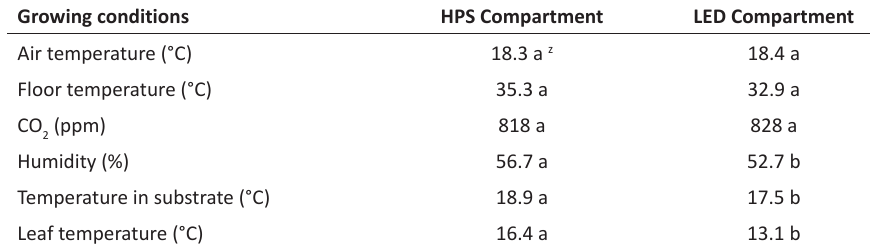
Table 1. Microclimate conditions, leaf temperature of red winter lettuce ( Lactuca sativa ‘Carmoli‘) and temperature of the substrate in the greenhouse compartments with either HPS or LED